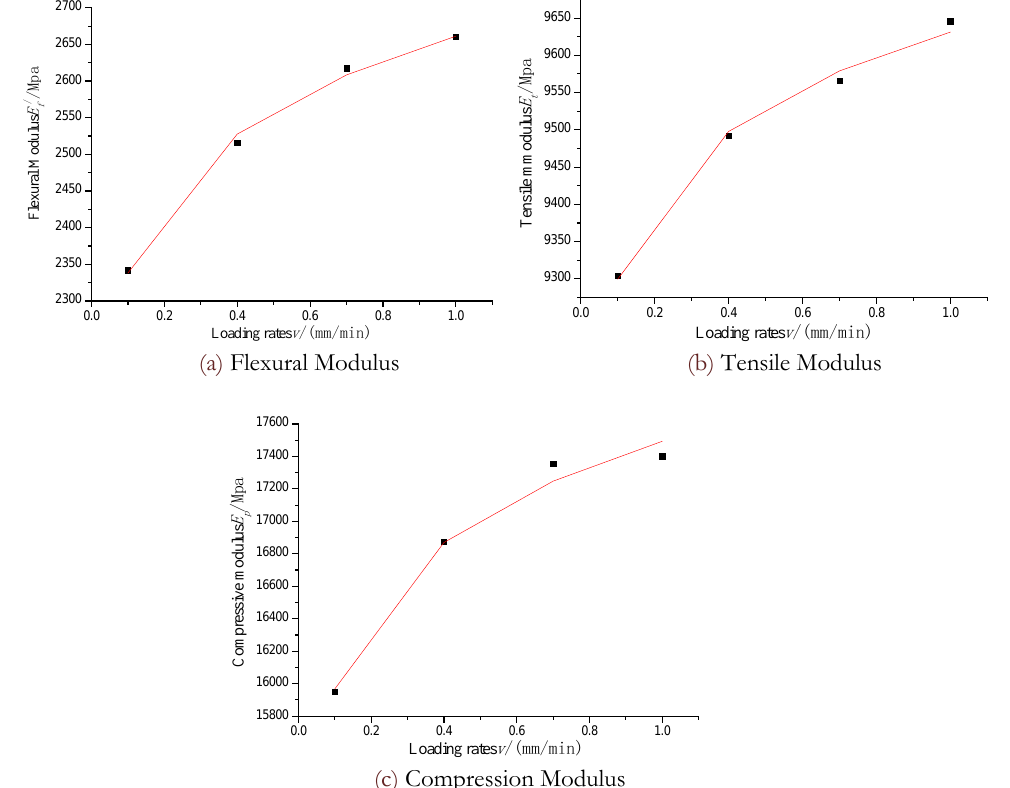
Figure 7: Change Rules of the Three Moduli with the Loading